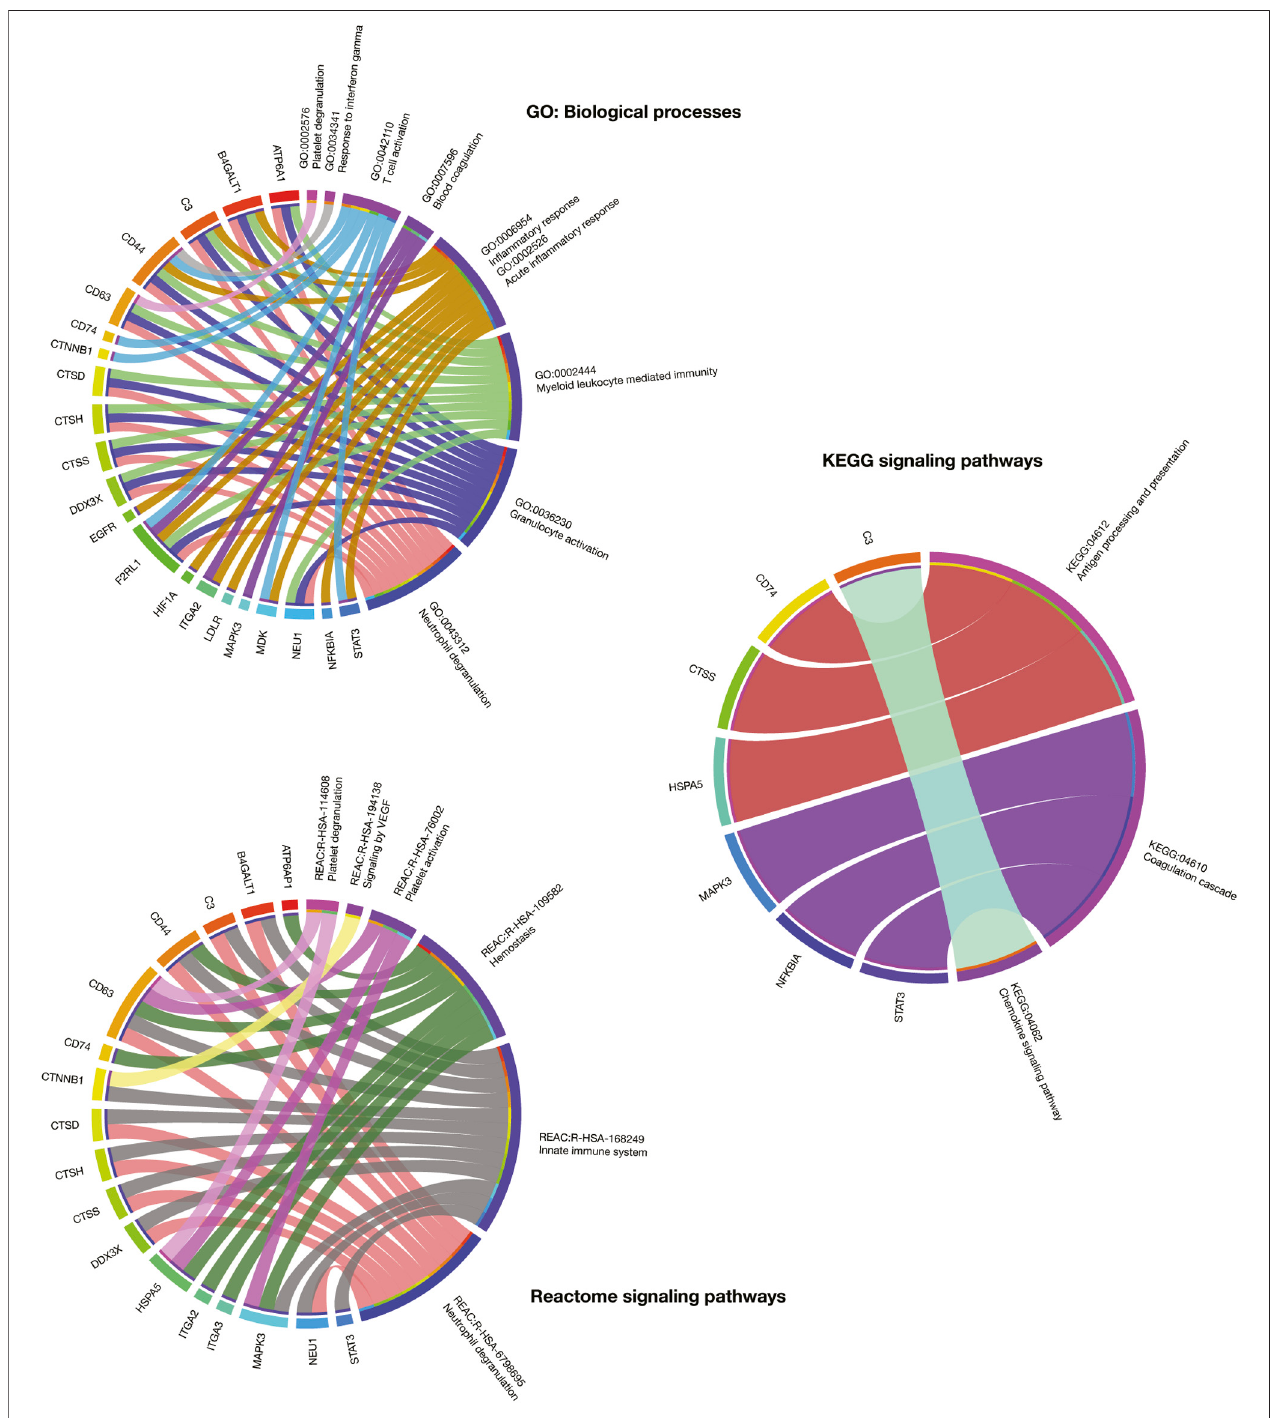
FIGURE 7 | Circos plots that detail association between GO: biological processes, KEGG signaling pathways, and Reactome signaling pathways and the most relevant immune system proteins for drug repurposing.